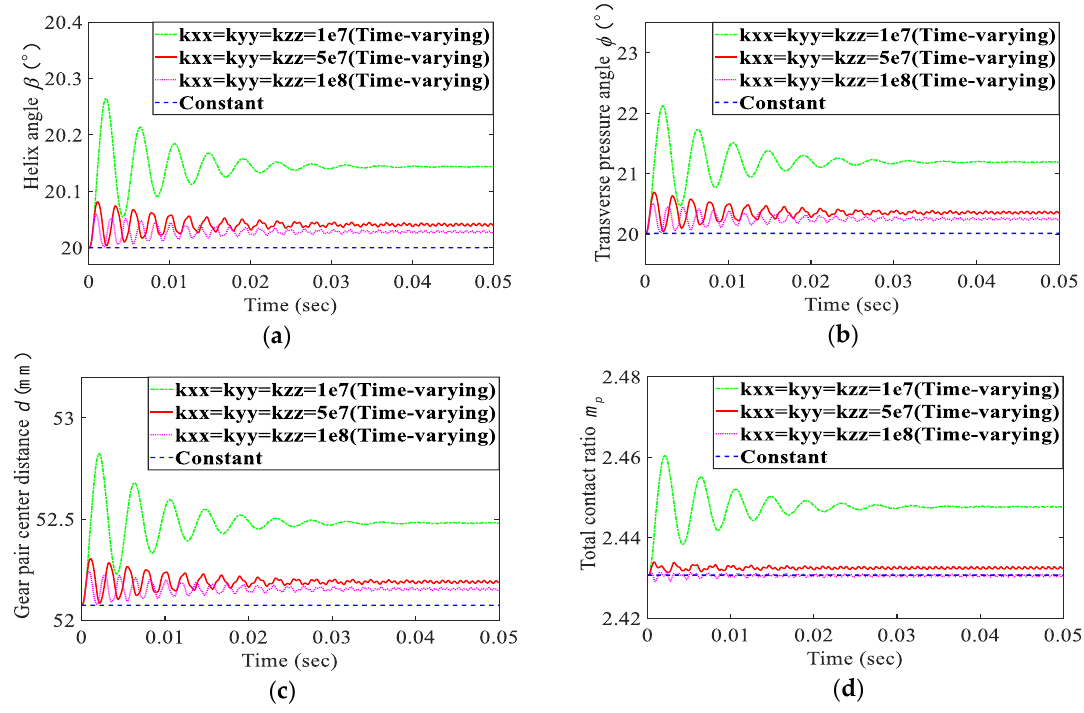
Figure 9. Time-varying and constant (a) helix angle, (b) transverse pressure angle, (c) gear pair center distance, and (d) total contact ratio under different degrees of the bearing stiffness.